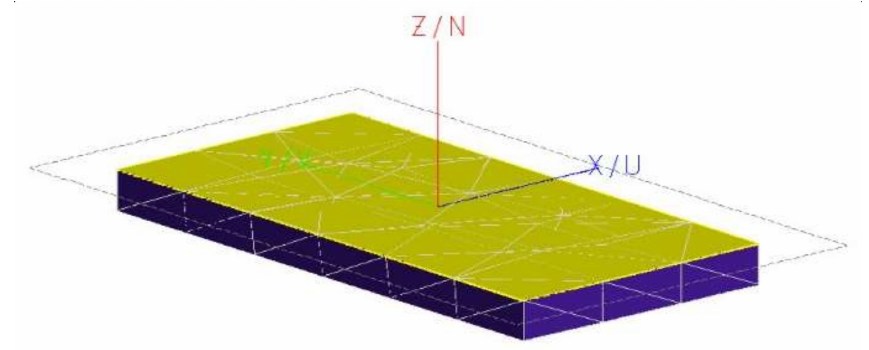
Figure 2. Geometric modeling of the trilayer graphene with the dielectric